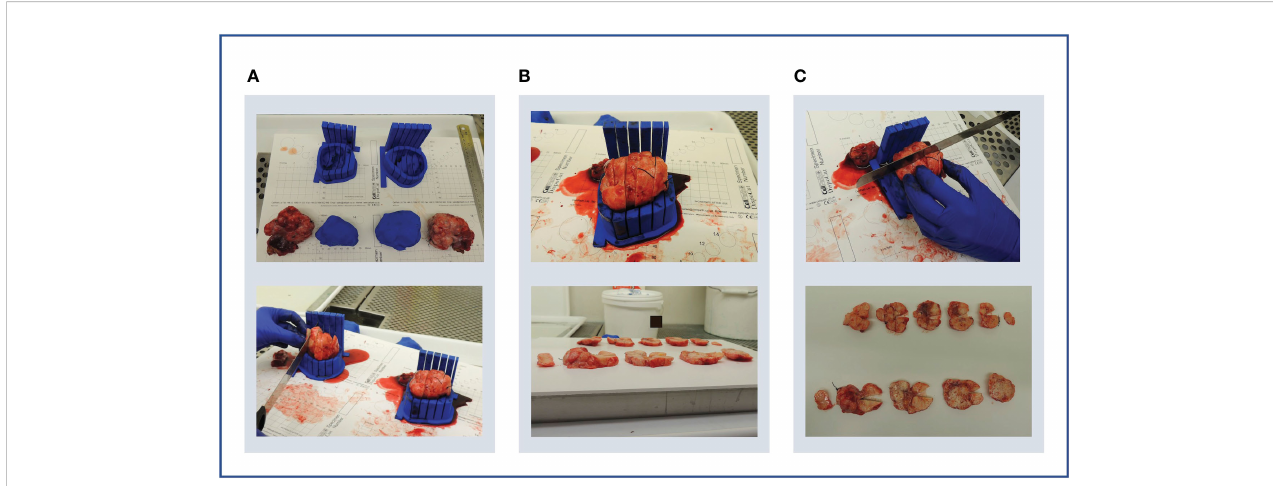
FIGURE 8 Case 3. (A) Upper panel: bilateral specimens with respective moulds and replicas. Lower panel: both specimens were sliced within their respective moulds. (B) Upper panel: due to shallow mould cavities and slice overspill, accurate cutting into 10 mm slices was challenging, and resulted in unequal